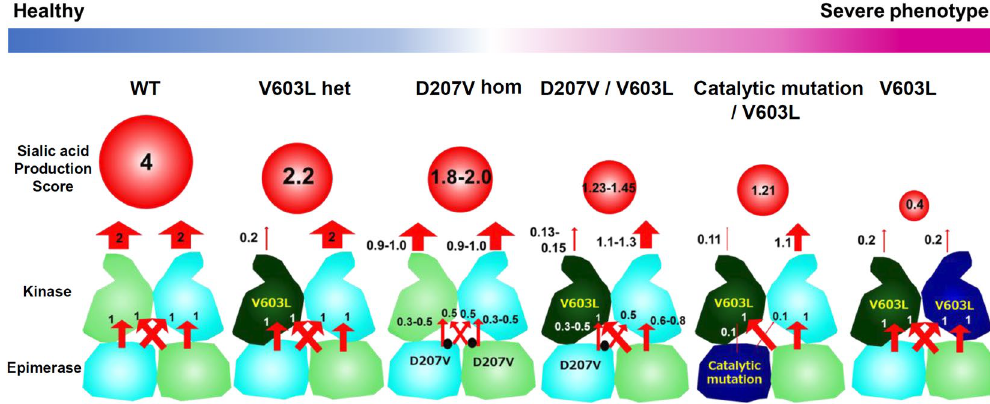
Figure 5. Model of ManNAc 6-phosphate production by mutated GNE. ManNAc 6-phosphate production ability was predicted as the sum of production route scores, which were calculated by multiplying the UDP- GlcNAc 2-epimerase reaction, ManNAc transfer, and ManNAc kinase reactions in the GNE dimer. Enzymatic reactions mediated by UDP-GlcNAc 2-epimerase and ManNAc kinase, and intramolecular and intermonomer ManNAc transfer in normal GNE dimer: Score 1. In GNE molecule with D207V, intramolecular ManNAc transfer may be affected: Score 0.5. Intermonomer transfer in GNE dimer with D207V is variable, due to failure of oligomerization: Score 0.3–0.5. In mutant GNE with catalytic mutations or V603L, both enzymatic reactions are affected: Score 0.1 and 0.2,